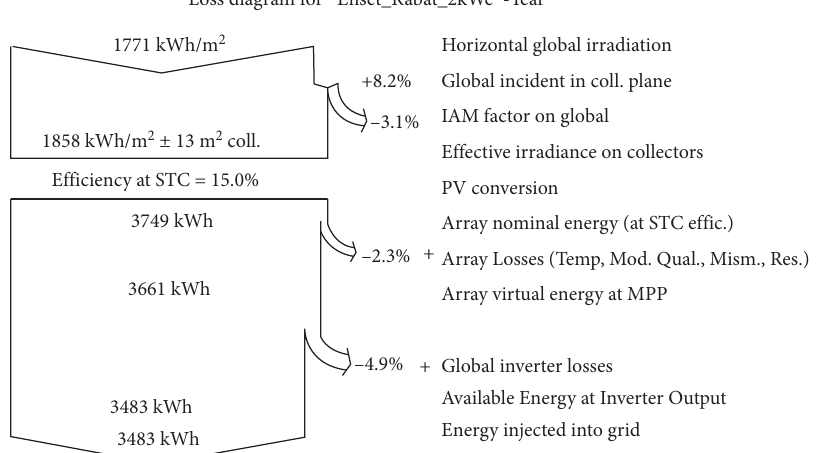
Figure 9: The loss diagram of the whole year for the ENSET PV system.